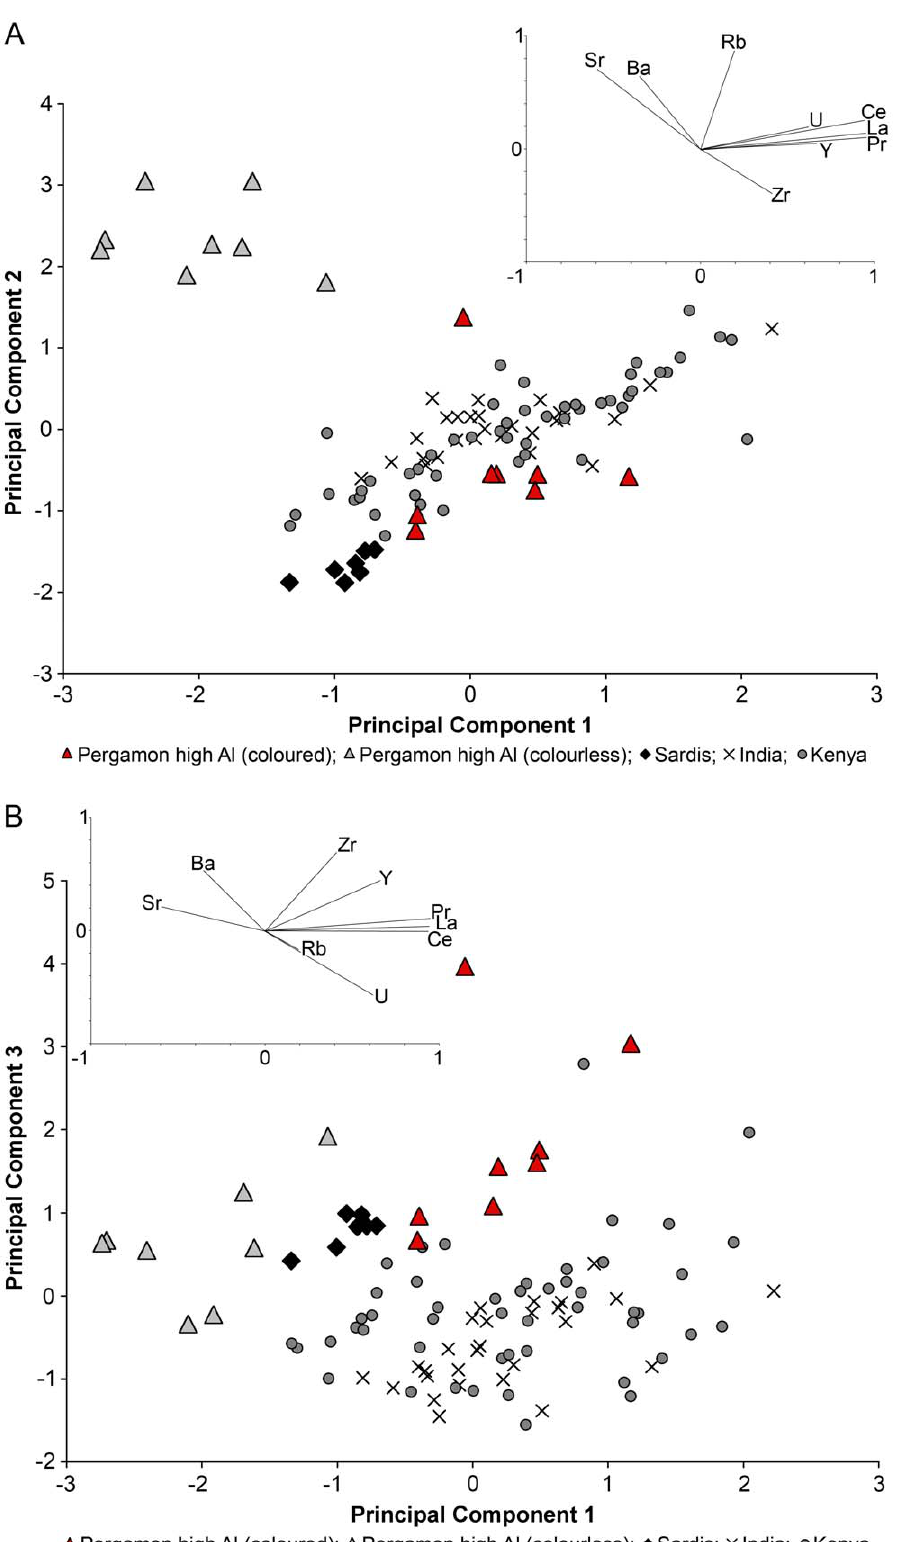
Figure 7. Principal component analysis of selected trace elements. The high alumina glasses from Pergamon, Sardis (by courtesy of Laure Dussubieux), India and Kenya [40] were analysed by PCA for the trace elements associated with the base glass composition (Sr, Ba, Rb, Ce, La, Pr, Y, Zr) in addition to uranium. Principal components PC1 and PC2 (A) or PC3 (B) distinguish the colourless and pinkish high alumina glasses from Pergamon (light grey triangles) from the other groups. The loading vectors illustrate that these samples have higher strontium and barium concentrations than